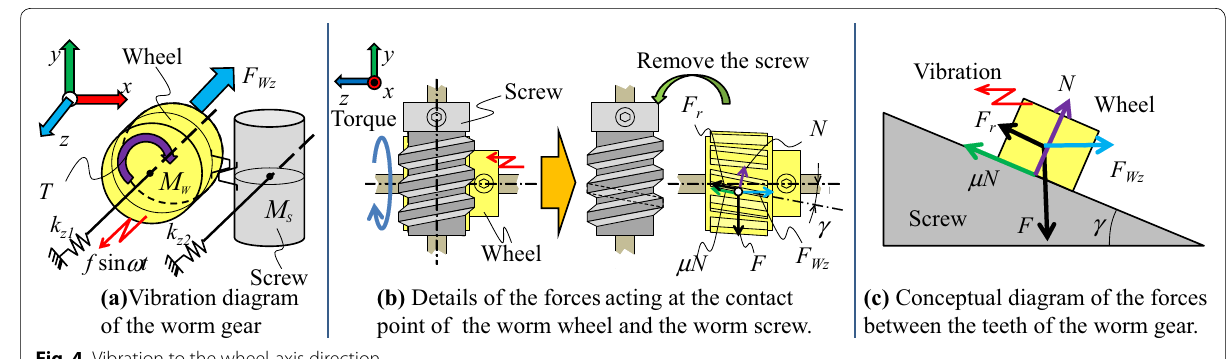
(c) Conceptual diagram of the forces between the teeth of the worm gear.